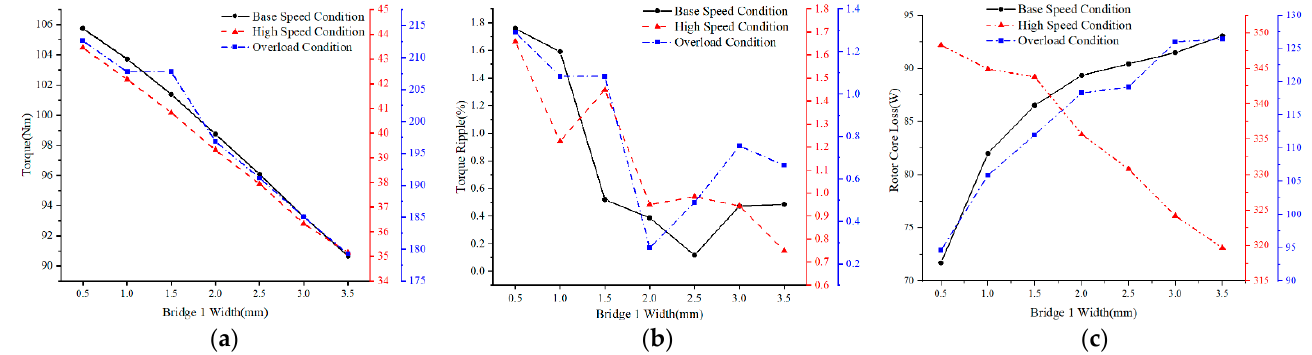
Figure 11. Motor electromagnetic characteristics with different bridge 1 width: ( a ) output torque, ( b ) torque ripple; ( c ) rotor core loss.